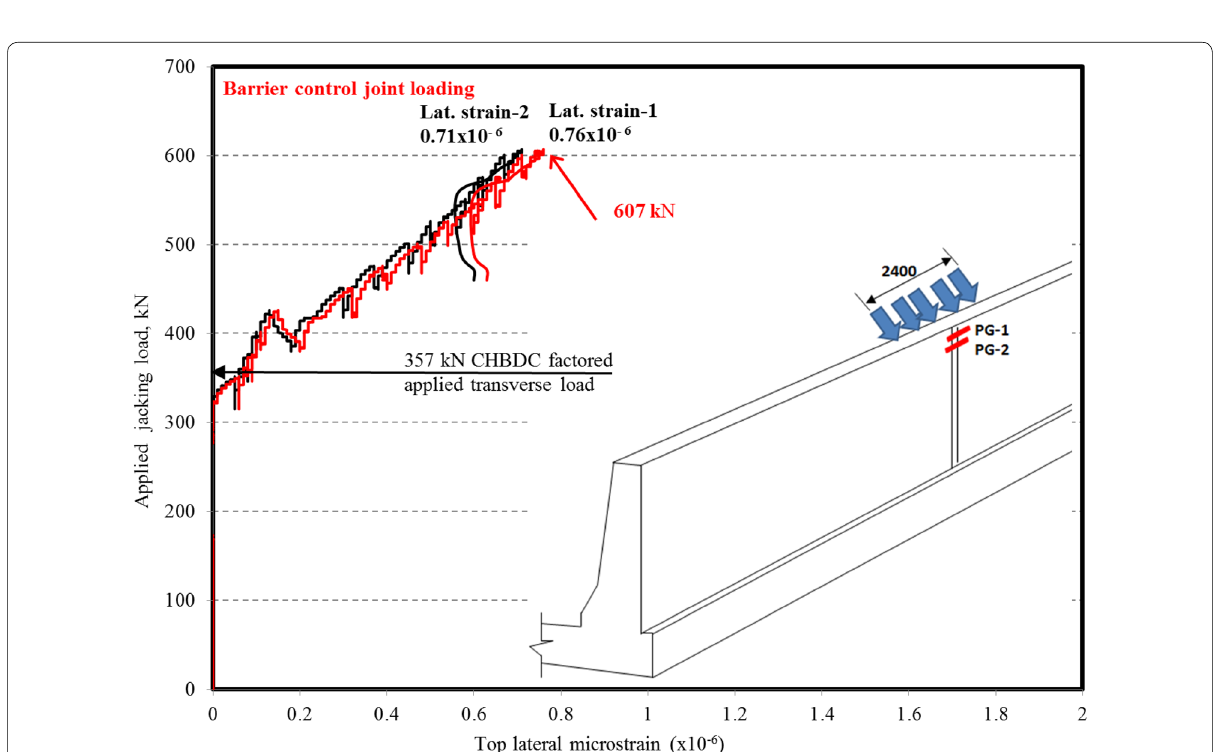
Fig. 12 Load-horizontal strain relationship at the top level of the barrier at control